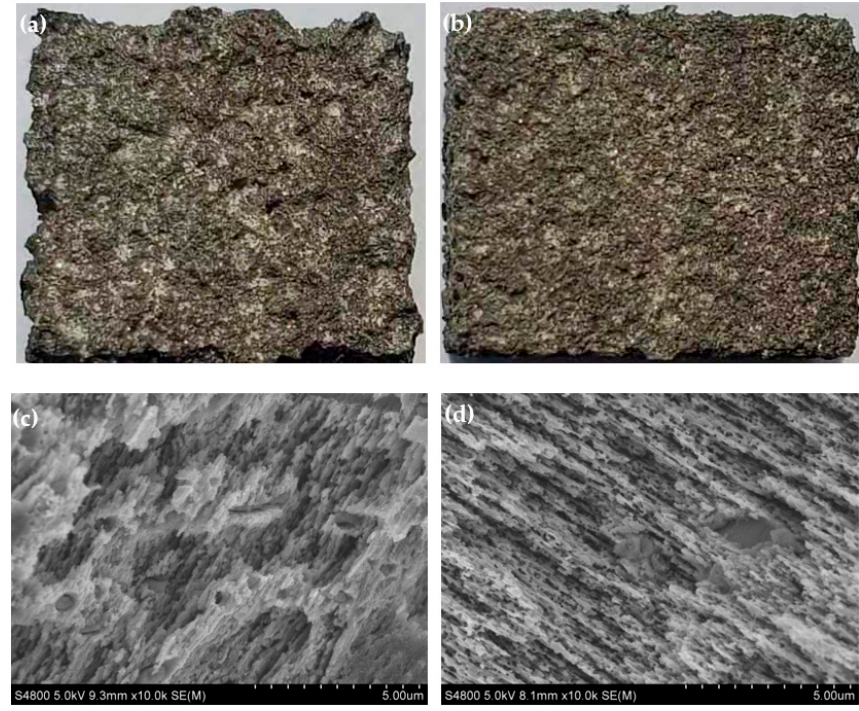
Figure 4. Macroscopic and SEM images of homogeneous TXC311 and TXCZ3111 alloys. ( a , c ) TXC311; ( b , d ) TXCZ3111.